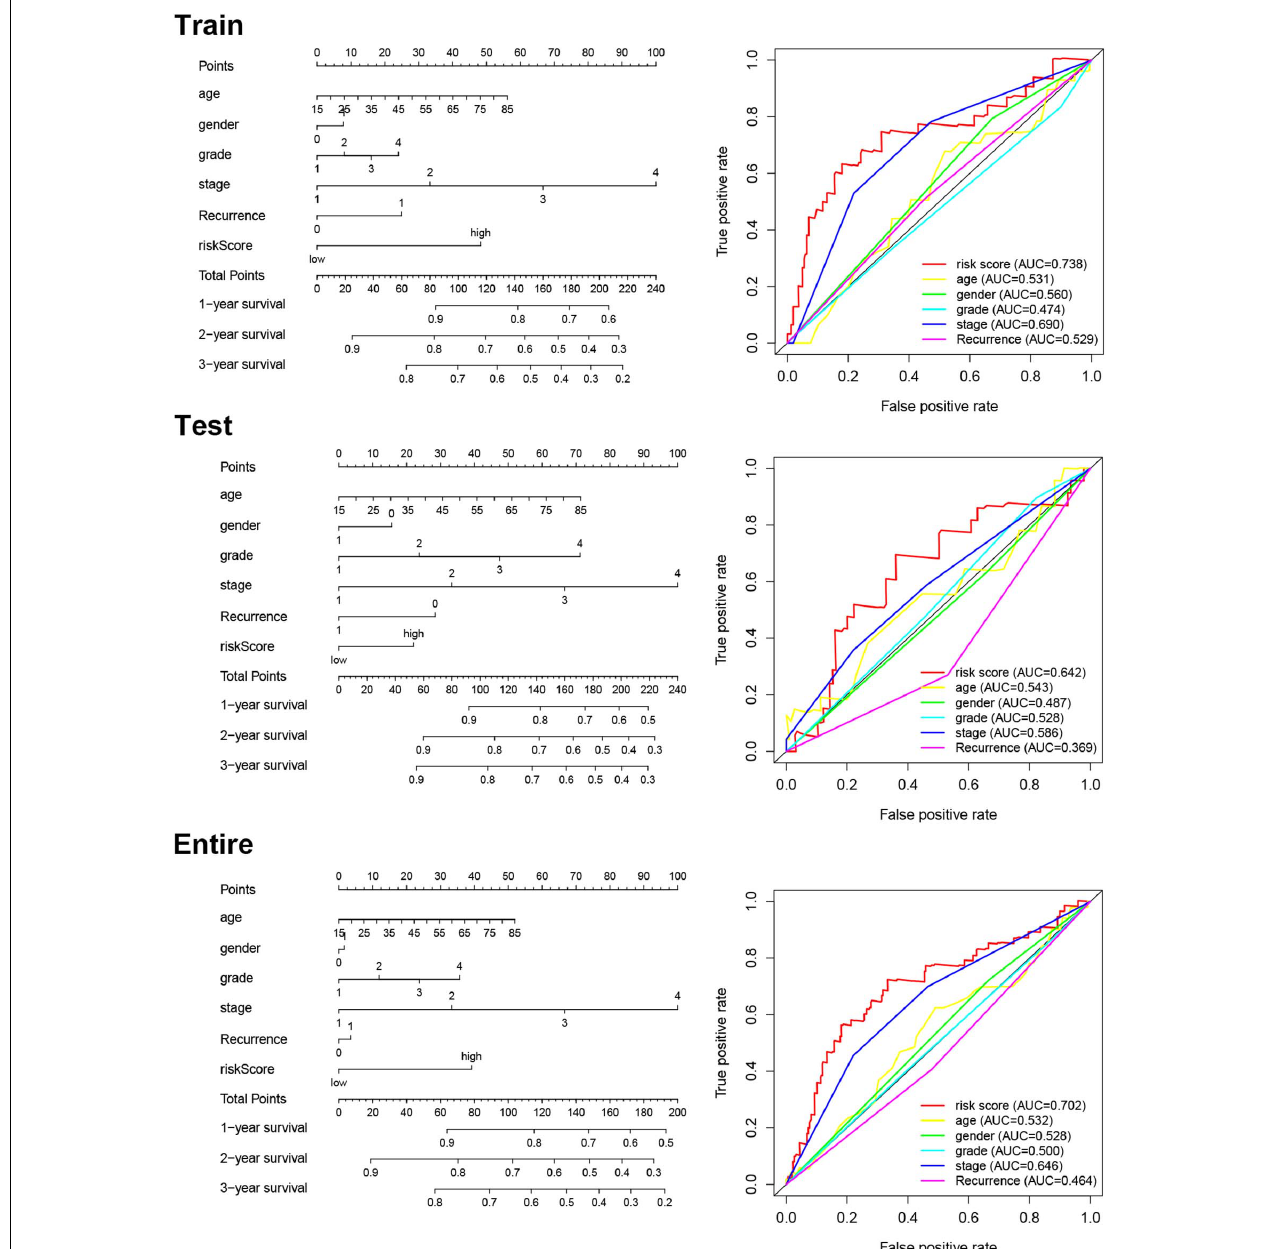
FIGURE 5 | Nomogram for predicting OS and ROC curves of the risk scores and clinical features in each cohort.